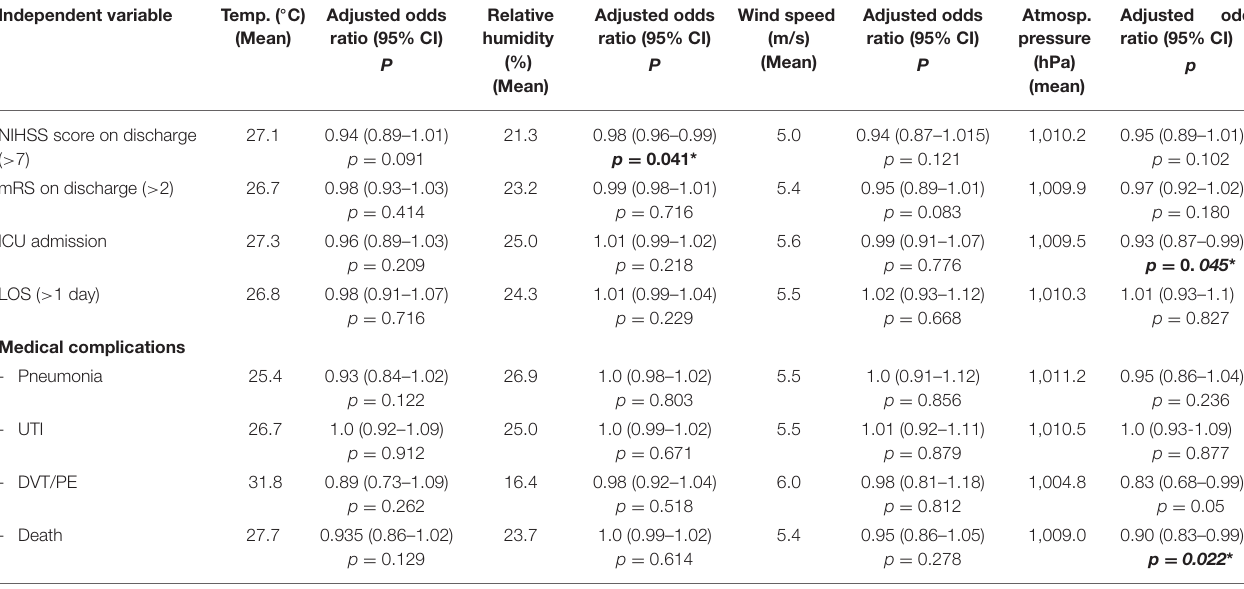
TABLE 3 | Multivariate regression analysis to examine the impact of 1-unit increase in the temperature, relative humidity, wind speed, and atmospheric pressure on stroke outcomes. Independent variable